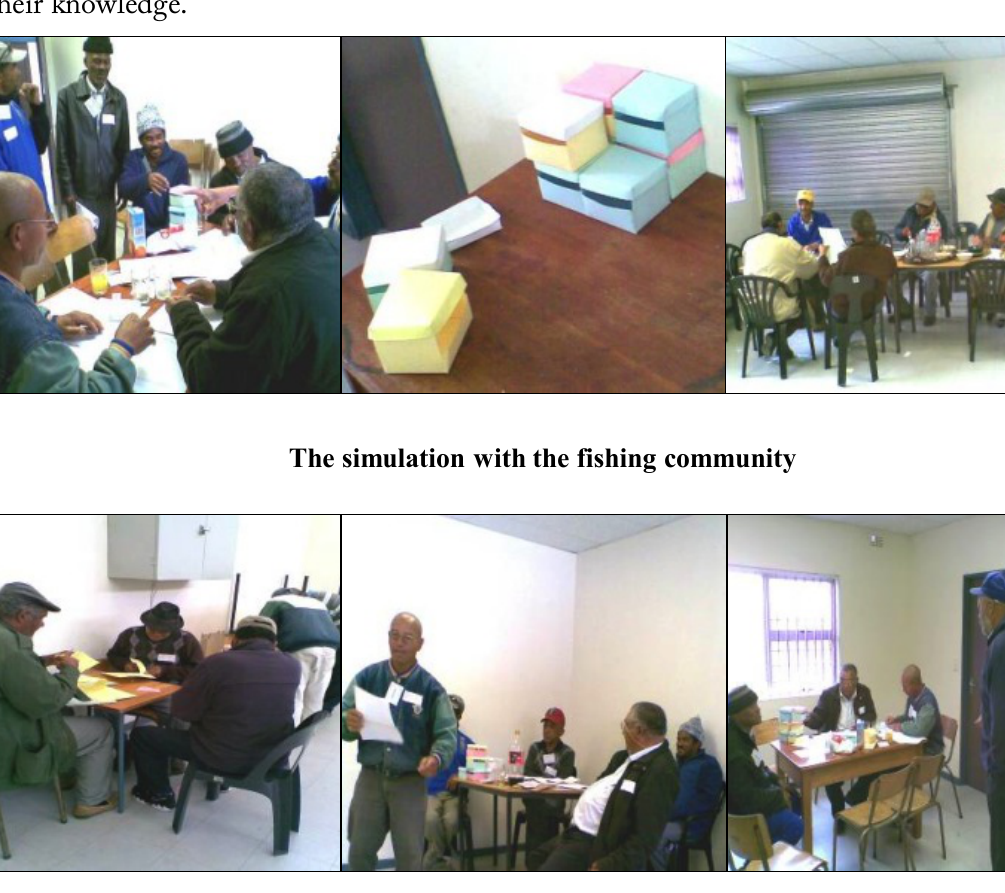
Figure 2: The simulation with the fishing community Feedback from the leaders regarding their experience of the simulation indicated that they saw hidden talent in the fishers. They also added that they would like to use role-play exercises in future with the fishers. Mention was also made that something new had happened in that all the fishers had come together. The simulation may have been an important boost of confidence for the fishermen and may also have demonstrated to them that they have underutilised capabilities. The emphasis on communication and participation was particularly